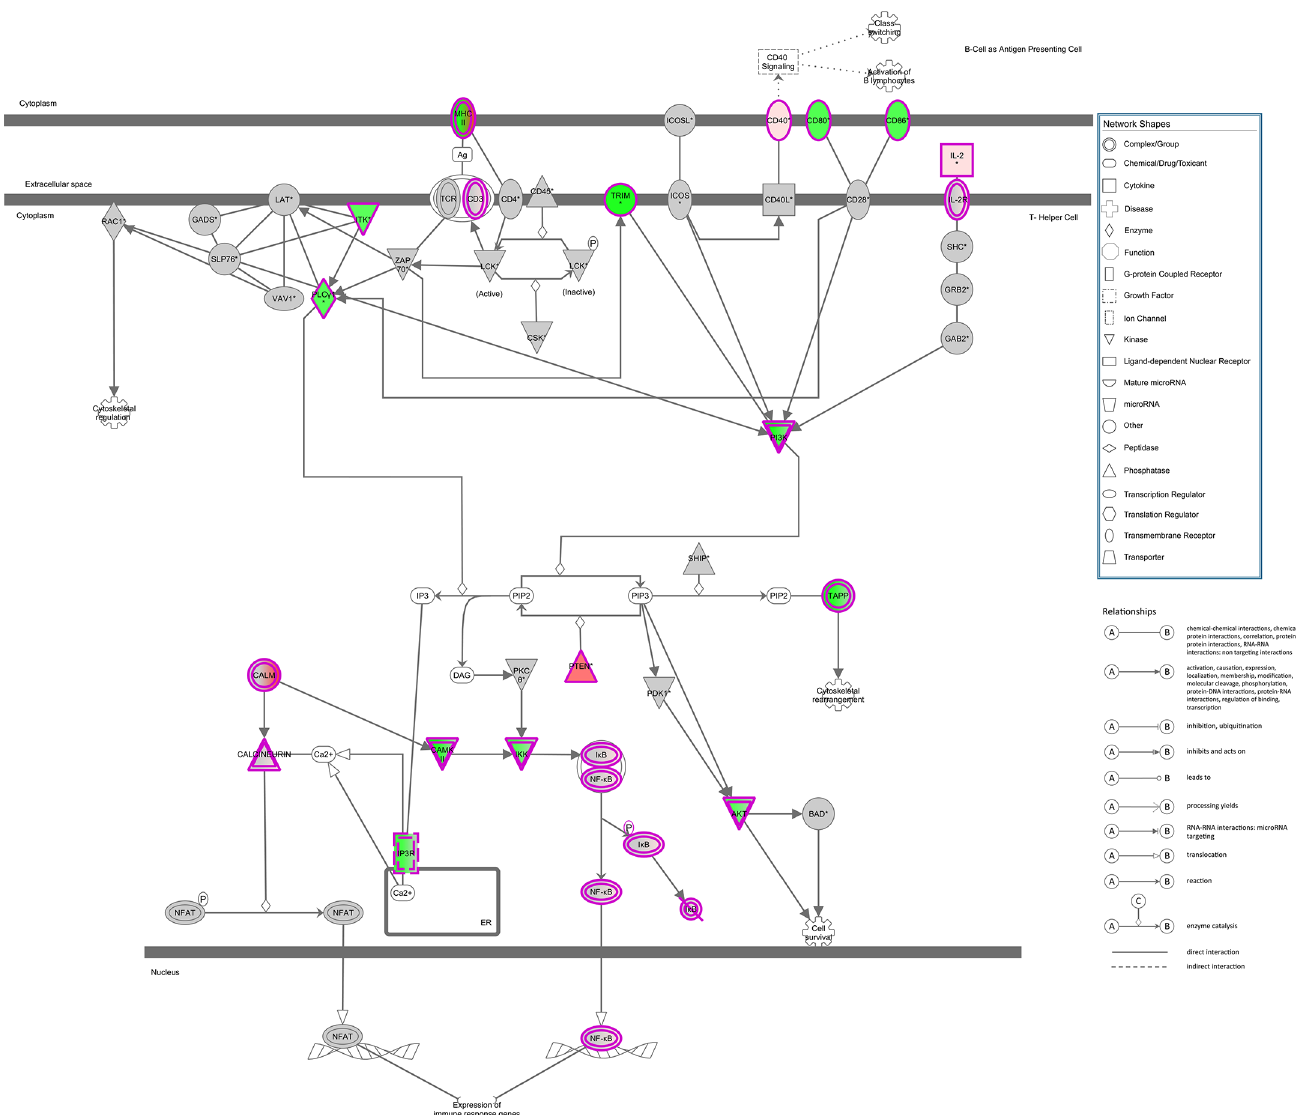
Fig 2. Top canonical pathway (iCOS-iCOSL Signaling in T Helper Cells) overlaid with hits from union of RIP-Seq and RNA-Seq analyses. Significant pathway nodes are shaded according to size of fold change (red > 1; green < 1), with white nodes indicating genes that were not detected in the samples and gray indicating genes that were detected, but not significant. Nodes with multicolor gradients denote nodes with significant genes with fold changes in different directions (see Table 2 for more details). Fold change is defined as KO/CTL (RNA-Seq) or IP/CTL (RIP-Seq). Colored double borders indicate that the molecule is a